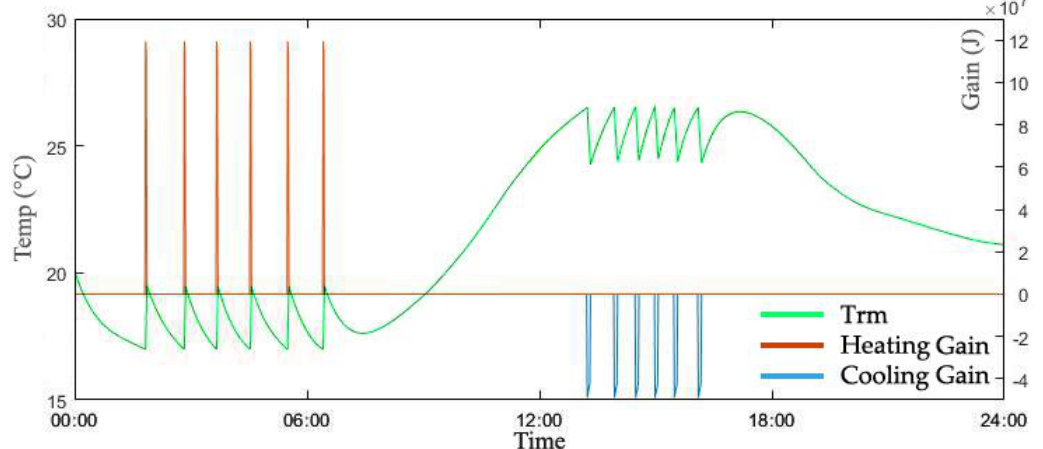
Figure 6. Changes of T rm and energy transfer by the thermostat control.